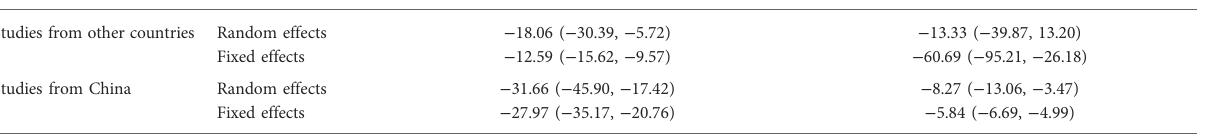
TABLE 3 In fl uence of statistical model on TXA ef fi cacy of in fl ammatory biomarker IL-6. Subgroup